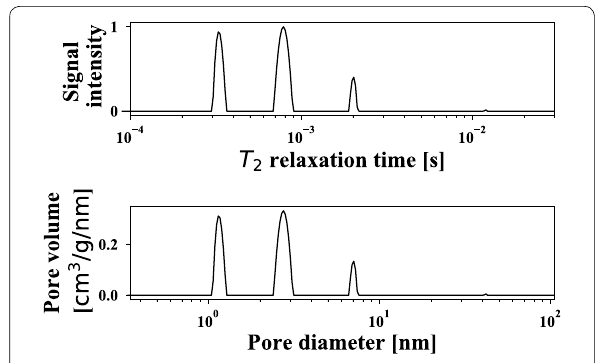
Fig. 7 1H-NMR results measured on white Portland cement: (top) Signal intensity versus T 2 relaxation time from CPMG; (bottom) inferred pore size